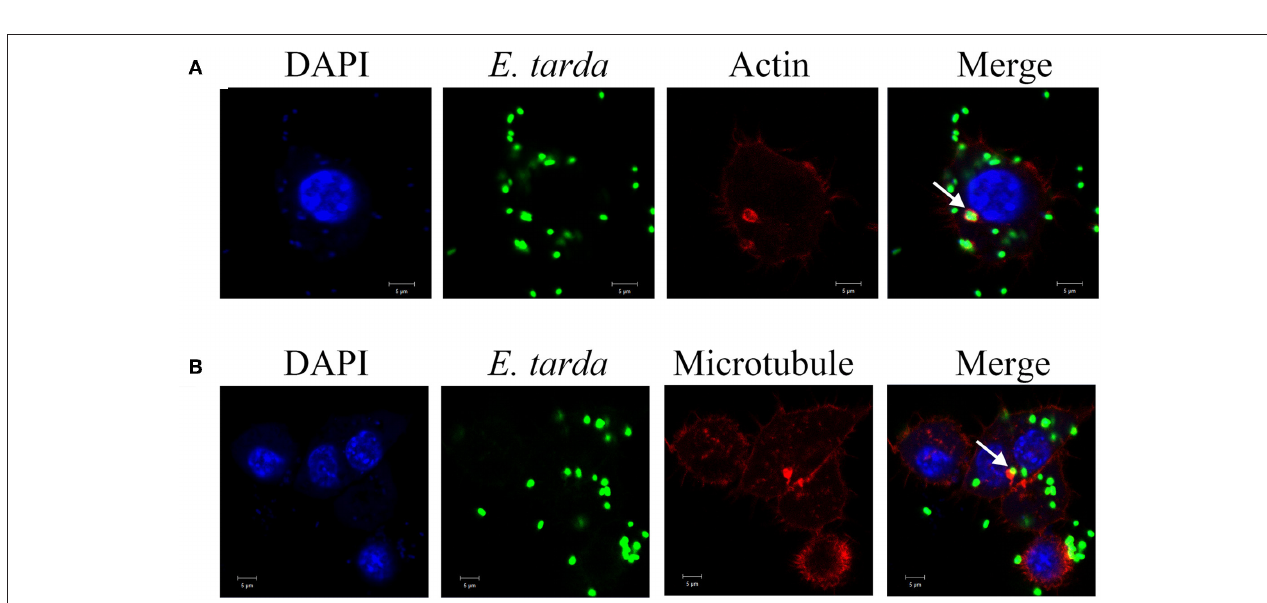
FIGURE 6 | Effects of actin (A) and microtubule (B) inhibition on Edwardsiella tarda infection. RAW264.7 was infected with E. tarda TX1G in the presence or absence (control) of the inhibitors against actin (A) or microtubule (B) , and cellular internalization of the bacteria was determined by plate count. Data are the means of three independent experiments and presented as means ± SEM. * P < 0.05, ** P < 0.01.